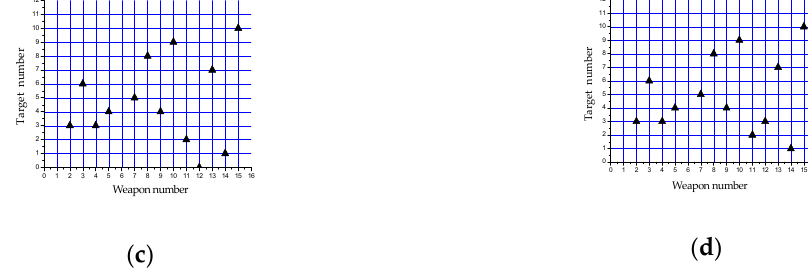
Figure 6. Target allocation scheme under different weapon consumption.